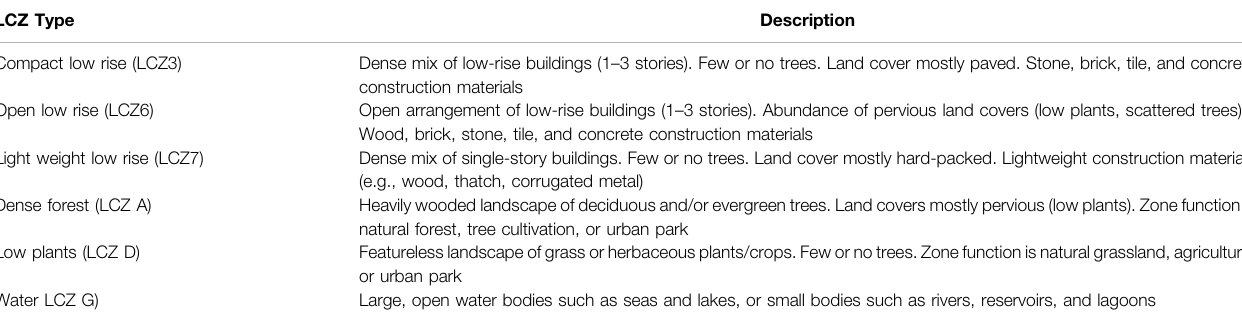
TABLE 3 | Description of LCZ categories identi fi ed in Bulawayo during fi eld